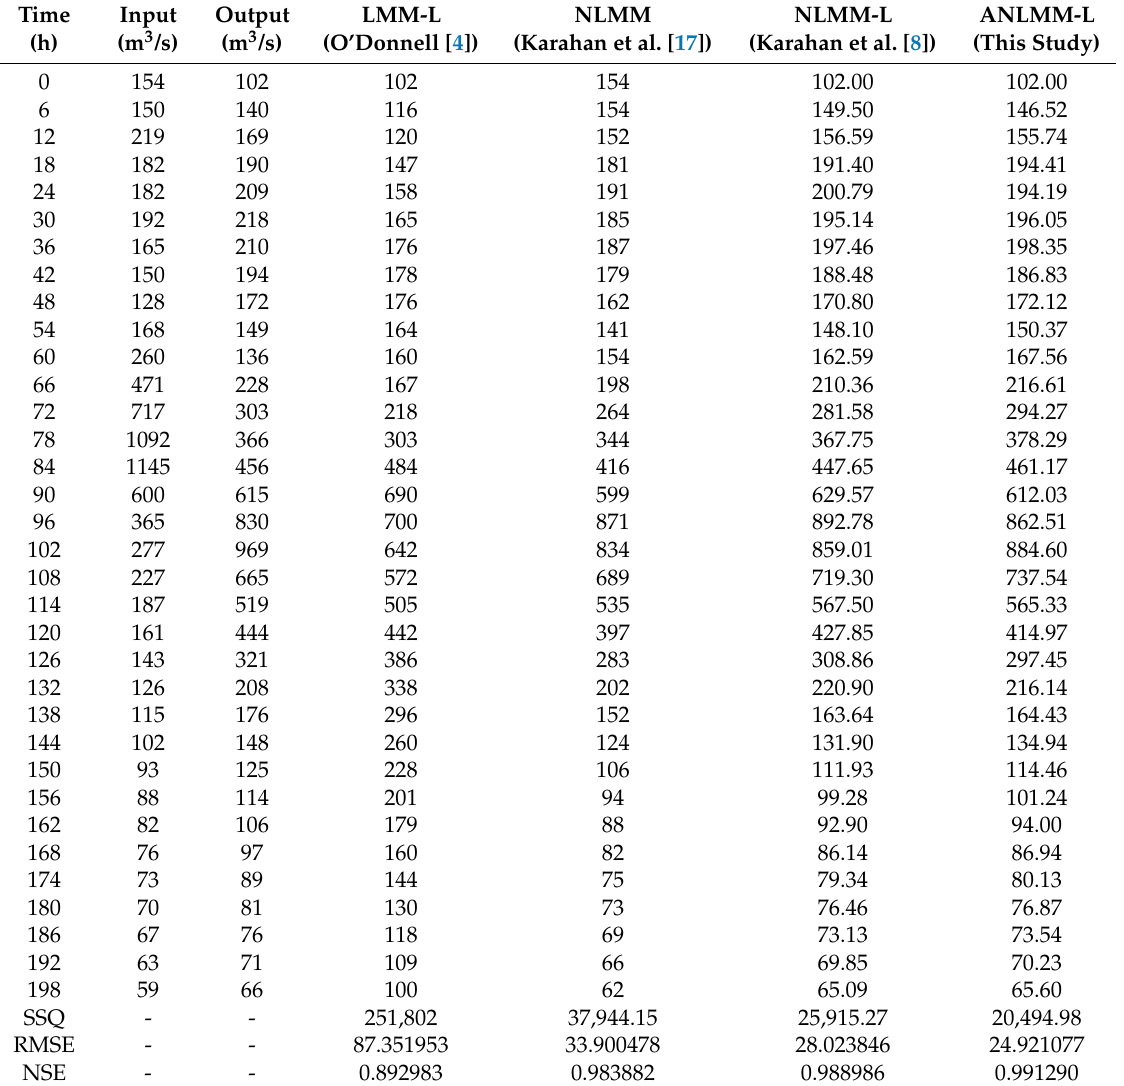
Table 6. Comparison of the outflow hydrographs calculated for the River Wye December in